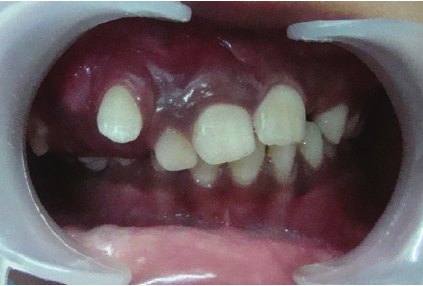
Figure 2: Intraorally unilateral reddish discoloration of gingiva (port wine stain) with osseous enlargement, drifting of teeth, and malocclusion.